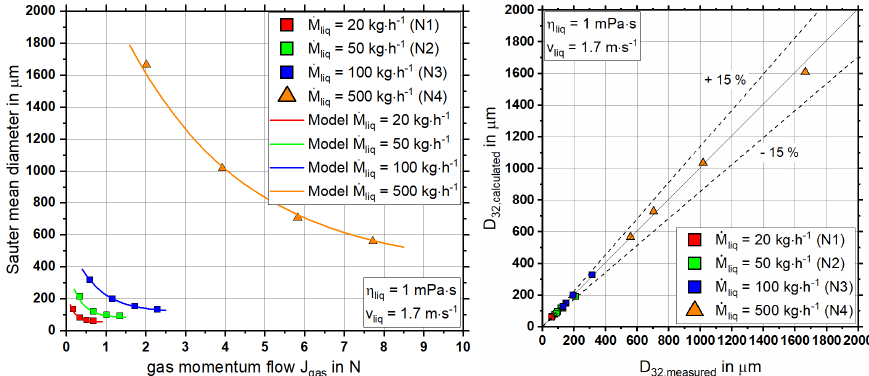
Figure 6. Integral Sauter mean diameter for varying gas momentum flow as symbols for measure- ments and lines as calculation of proposed scaling model ( left ); parity plot for deviation observation between measured and calculated droplet sizes via proposed model ( right ). Symbols: (cid:3) stands for data from PDA; (cid:52) represents data from high-speed